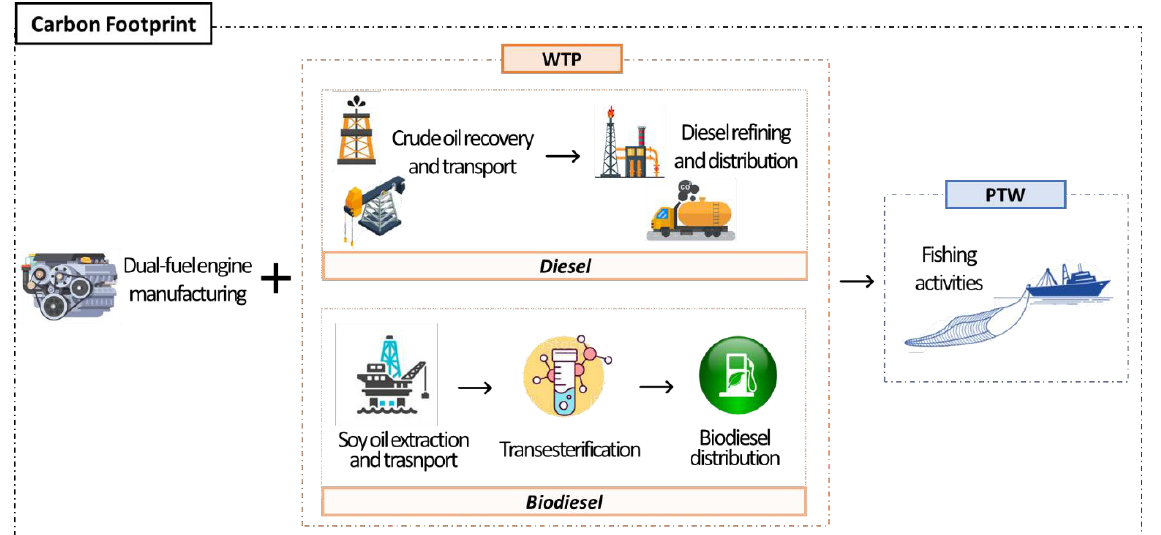
Figure 10. The LCA of a B20-powered trawler.